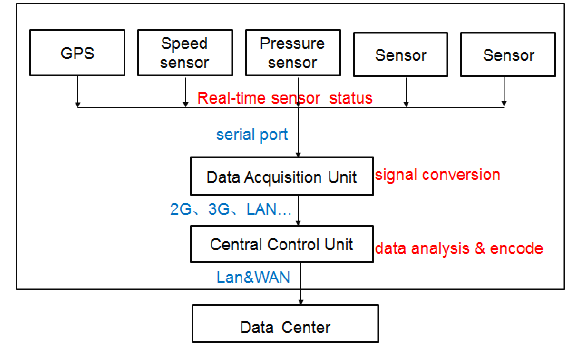
Figure 2. The Data flow of Data Acquisition Tier